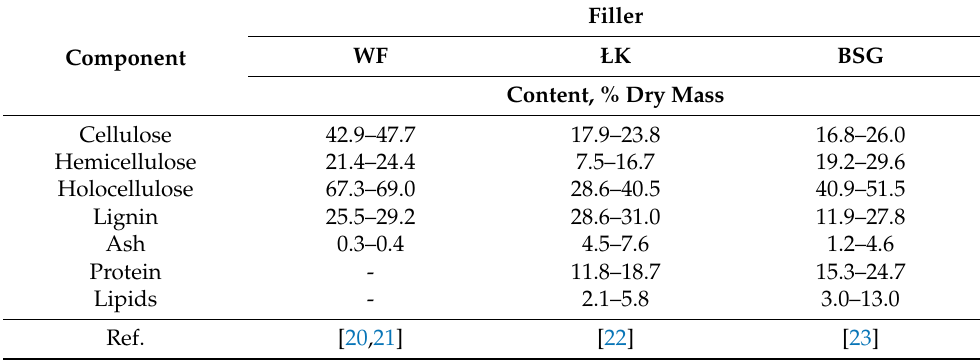
Table 1. Literature reports on the composition of applied fillers.